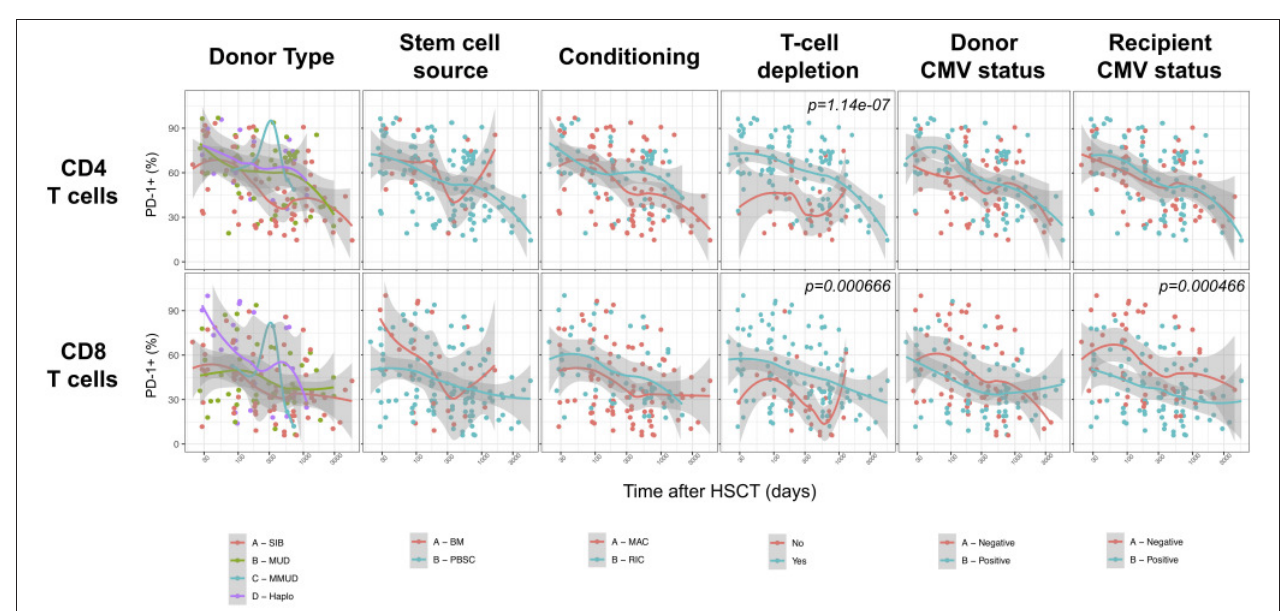
FIGURE 3 | from HC are represented. The p -values of expression in HSCT recipient groups at 1, 3, 6, 12, and > 24 months compared with HC are indicated (Mann-Whitney U -test; * p < 0.05, ** p < 0.01, *** p < 0.001, **** p < 0.0001). (B) Pie charts representing co-expression of 2B4 and CD160 by PD-1 negative (blue gradient colors) and PD-1 positive (red gradient color) CD4 (upper pies) or CD8 (lower pies) T cells. Arcs represent single molecules expression accordingly to the indicated colors. (C) Proportions of PD-1, 2B4, and CD160 co-expressing CD4 or CD8T cell subsets in HC and HSCT recipients. The p -values of expression in HSCT